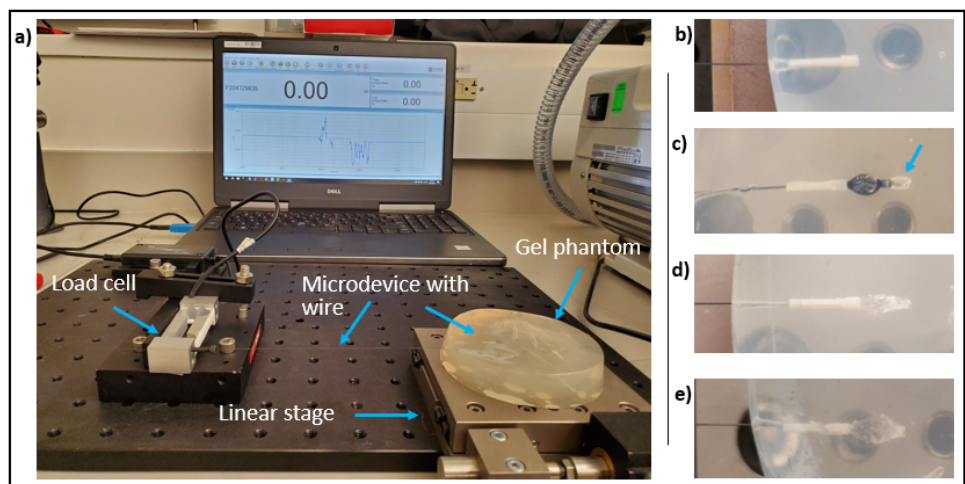
Figure 3. ( a ) Experimental set-up for microdevice stability force testing. A load cell is used to measure the tensile force required to displace a microdevice in a phantom model. Non-anchored ( b ), nitinol-anchored ( c ), low-absorption hydrogel-anchored ( d ), and high-absorption hydrogel-anchored ( e ) microdevices are well seen in the phantom. Microdevice displacement is also easily detected under direct visualization (blue arrow in c ). The force at which displacement/dislodgement is first visualized is recorded and compared between each anchoring method.